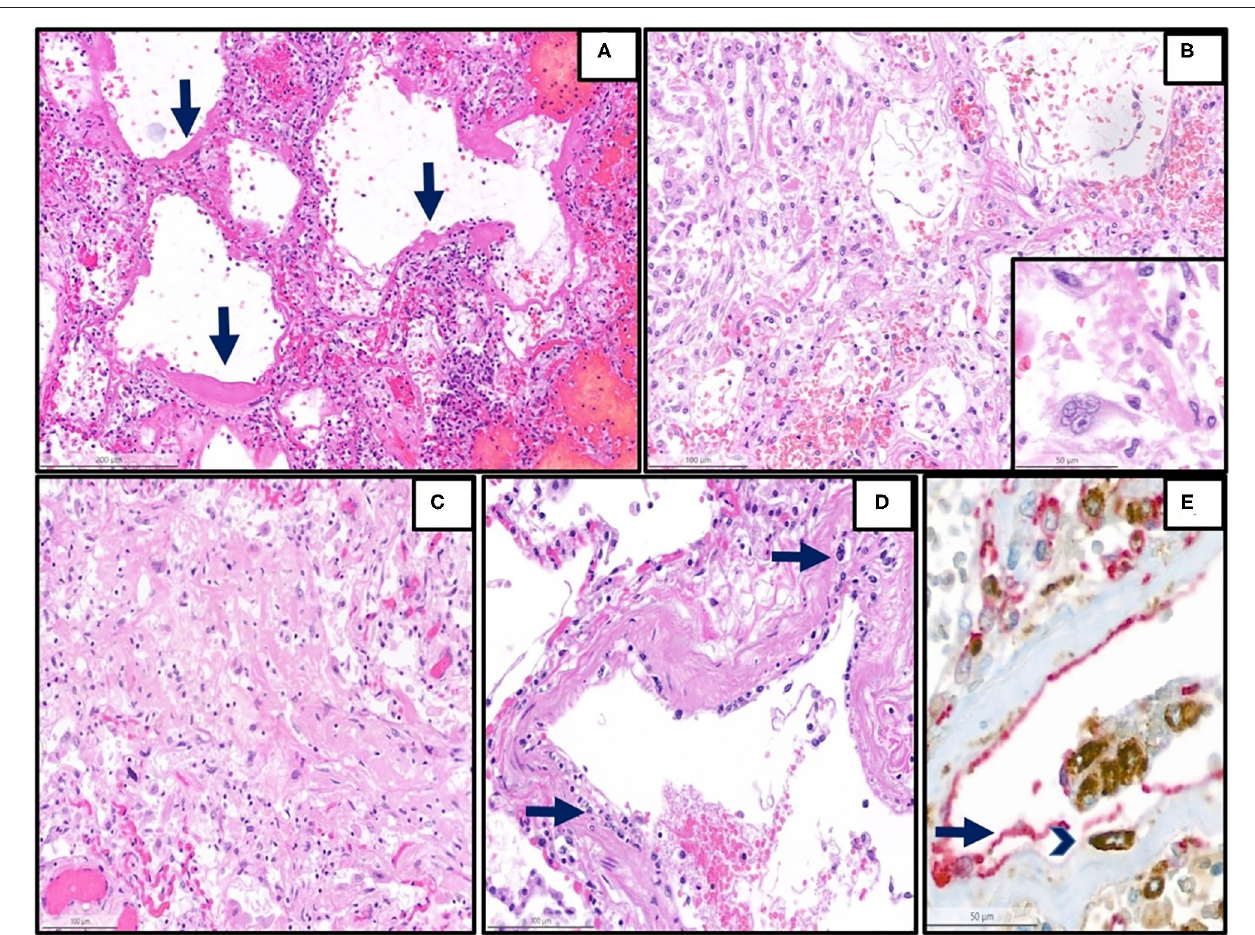
FIGURE 1 | Representative histopathological findings in autopsies from the first wave. (A) Lung tissue with diffuse alveolar damage in the exudative phase (hematoxylin and eosin (H&E), magnification 13 x, arrow: hyaline membranes). (B) Lung tissue with diffuse alveolar damage in the proliferative phase, which is defined by the presence of organization of the intra-alveolar and interstitial exudate, infiltration with chronic inflammatory cells, and interstitial myofibroblastic reaction. Proliferation and reactive atypias of type II cells are also noted (H&E, magnification 20 x). Inset: reactive pneumocytes type II, magnification 40 x). (C) Lung tissue with diffuse alveolar damage in the proliferative phase, showing an excessive collagen deposition (H&E, magnification 20 x). (D) Lung arterioles with endotheliitis, which is defined by the presence of subendothelial mononuclear inflammatory infiltrates (arrows) and damage of the endothelium (H&E, magnification 25 x) (E) Double immunohistochemistry [red: CD31 (endothelial marker), brown: CD68 (monocytic/macrophage marker)] of another representative case with endotheliitis shows endotheliitis of a venule in the lung with endothelial damage (arrow) and detachment with an associated mononuclear infiltrate (arrowhead) (H&E, magnification 28